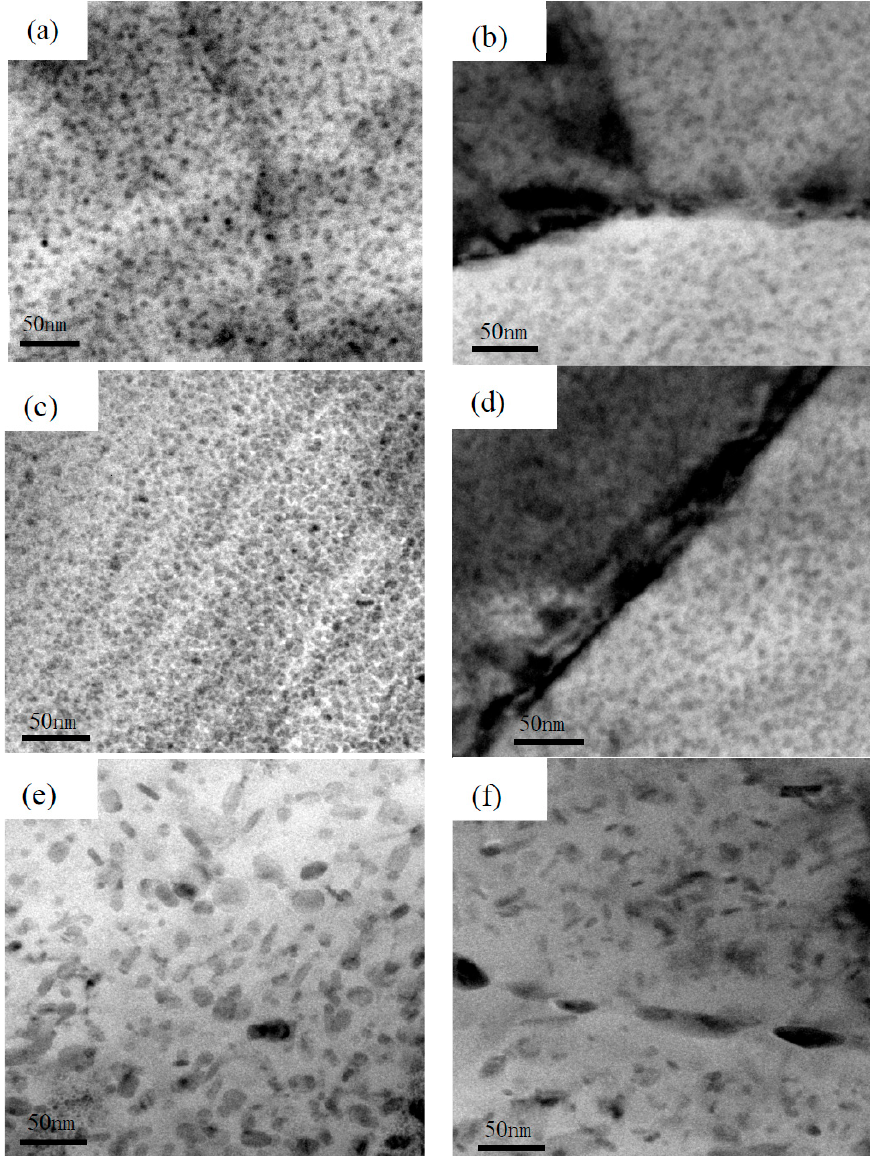
Figure 9. TEM bright field images of 7050 aluminum alloy with different aging states. ( a , b ) under aged (8 h); ( c , d ) peak aged (16 h); ( e , f ) over aged (24 h).